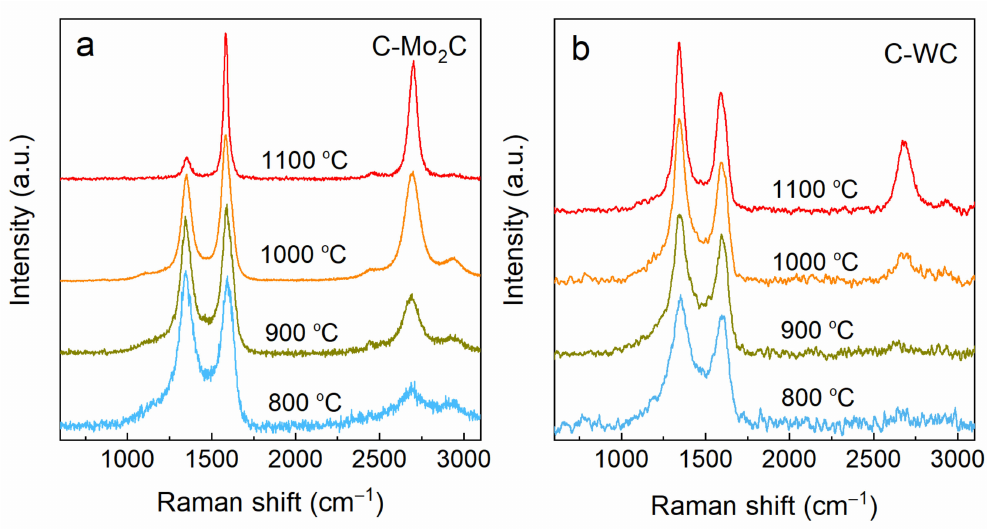
Figure 2. The Raman spectra normalized to the G-band intensity measured with excitation laser wavelength 514 nm (laser energy E L = 2.41 eV) for CDCs synthesized from ( a ) Mo 2 C and ( b ) WC at different T syn (noted in